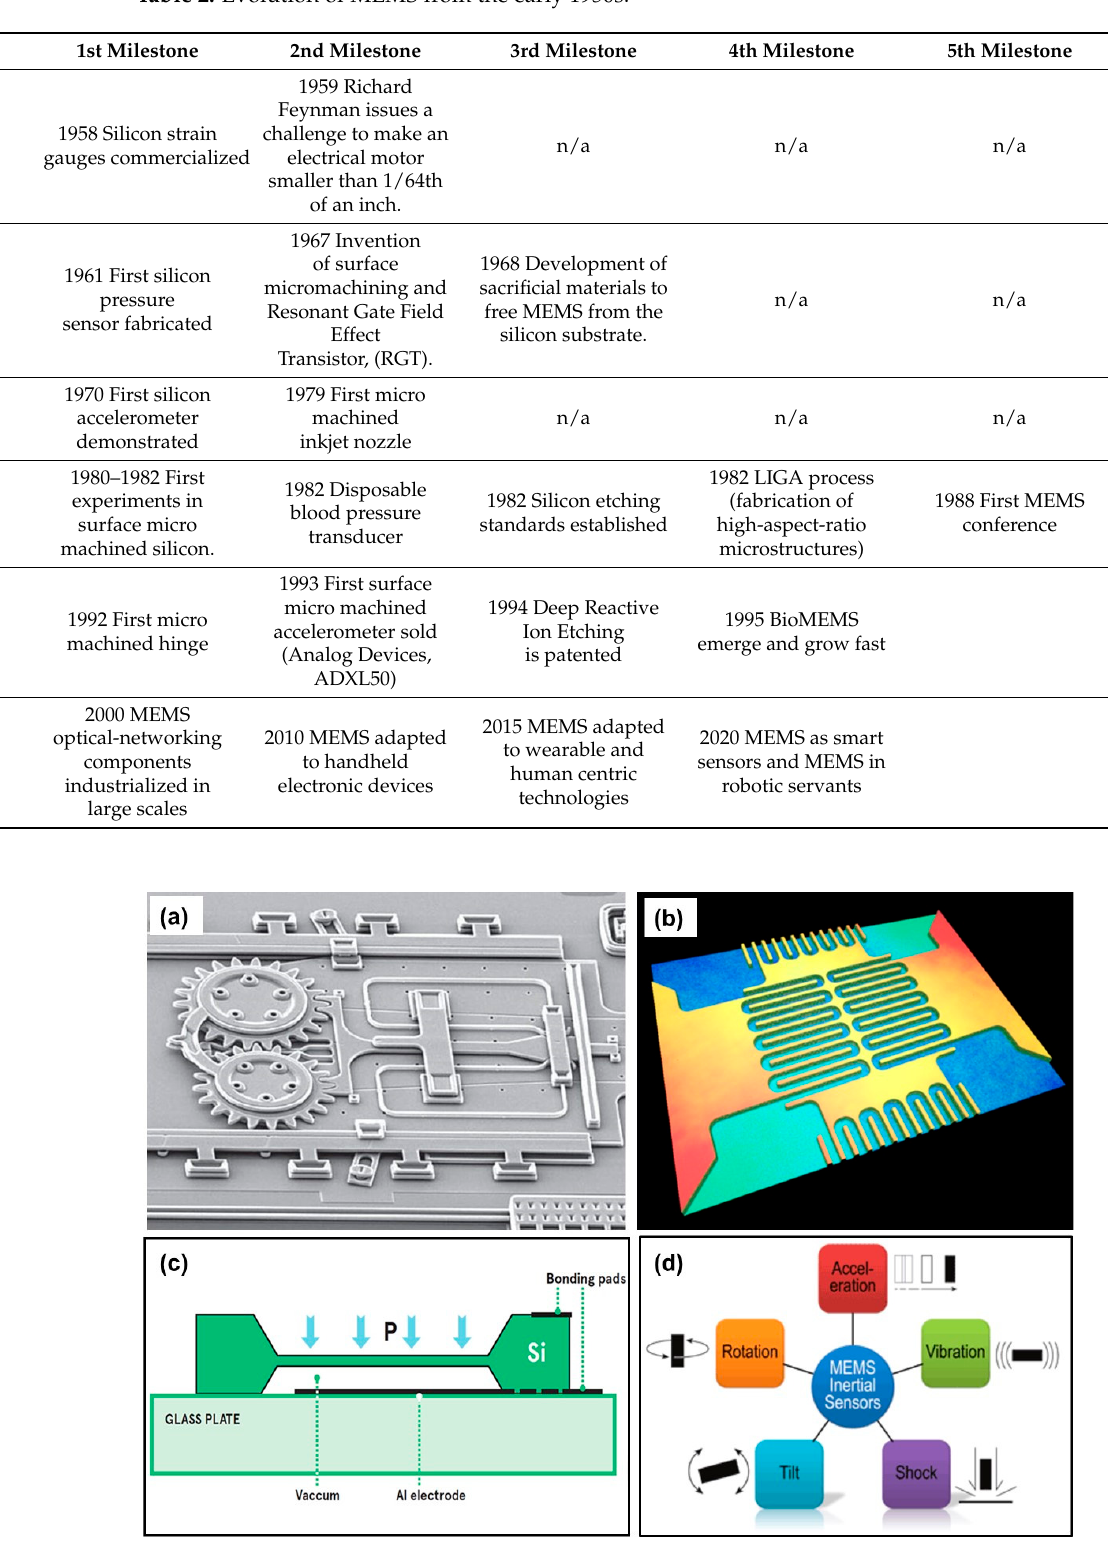
Table 2. Evolution of MEMS from the early 1950s.